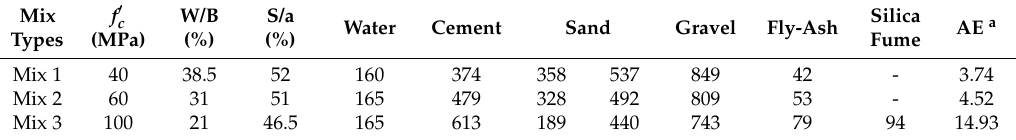
Table 1. Mix proportions of concrete (unit: kg/m 3 ).